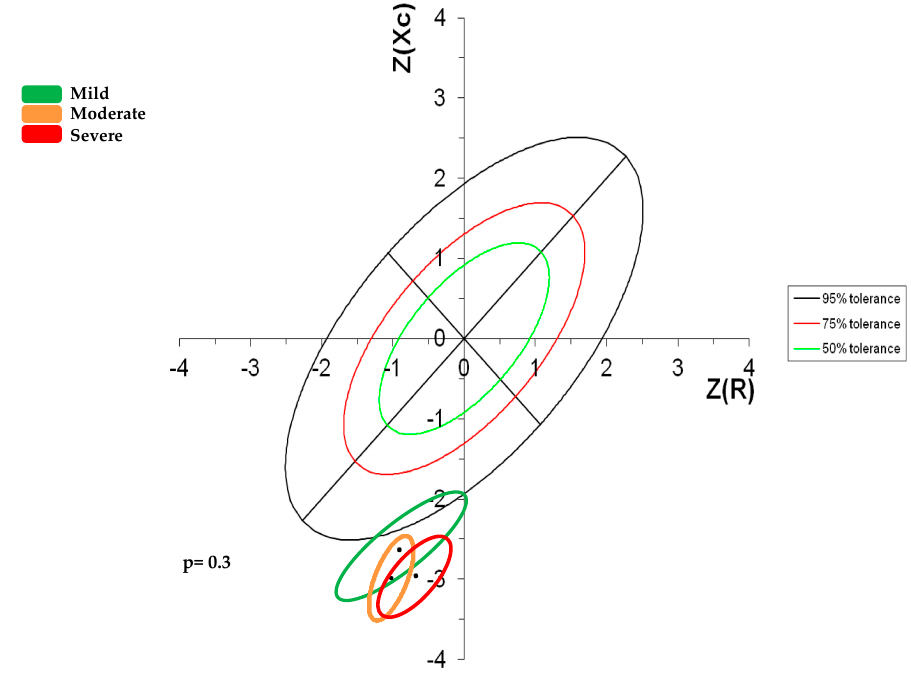
Figure 4. Z Score of bioelectric impedance vectors in geriatric patients according to the severity of GIS.